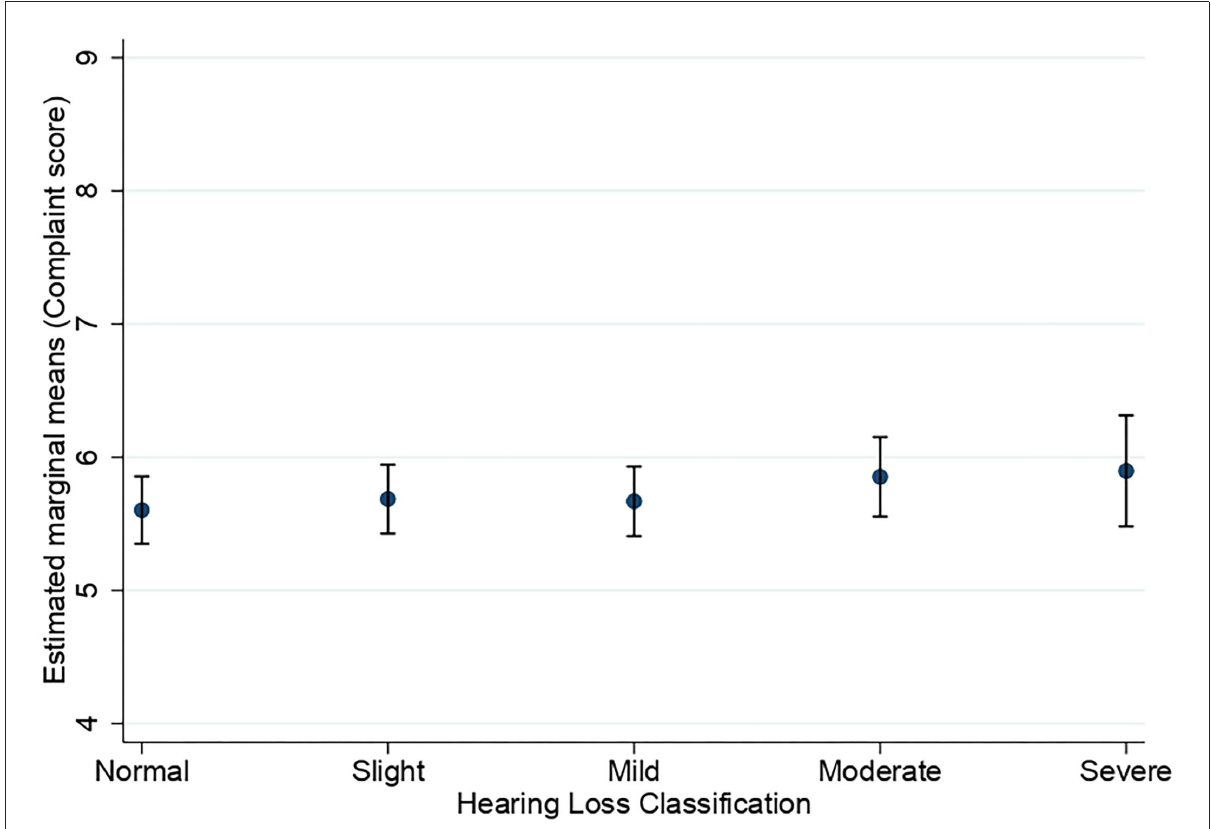
FIGURE2 Estimated marginal means of subjective short-term memory complaints as a function of hearing status. Estimates are averaged over the levels of age at the means of the covariates sex, education, stroke, diabetes, smoking, and hospital admission for a head injury. The error bars indicate 95% confidence